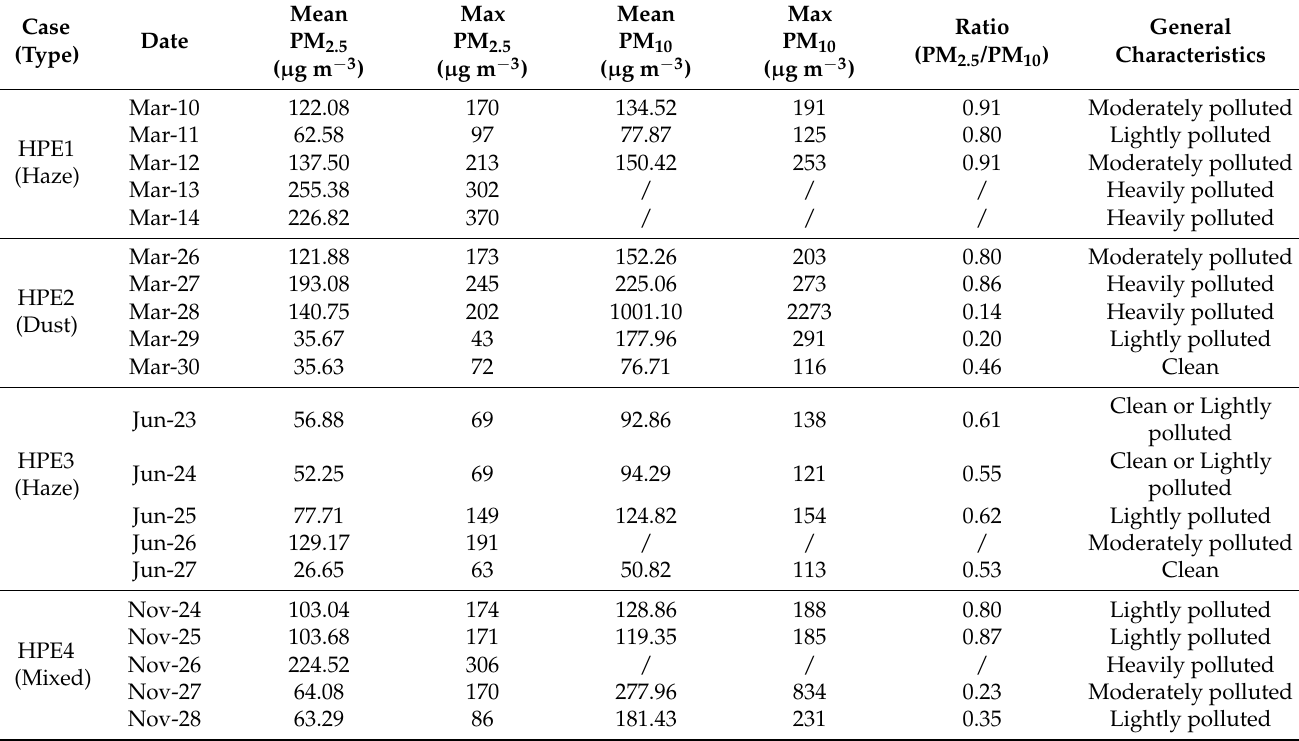
Table 2. Statistical summary of PM concentration in four polluted events (HPE1, 2, 3, and